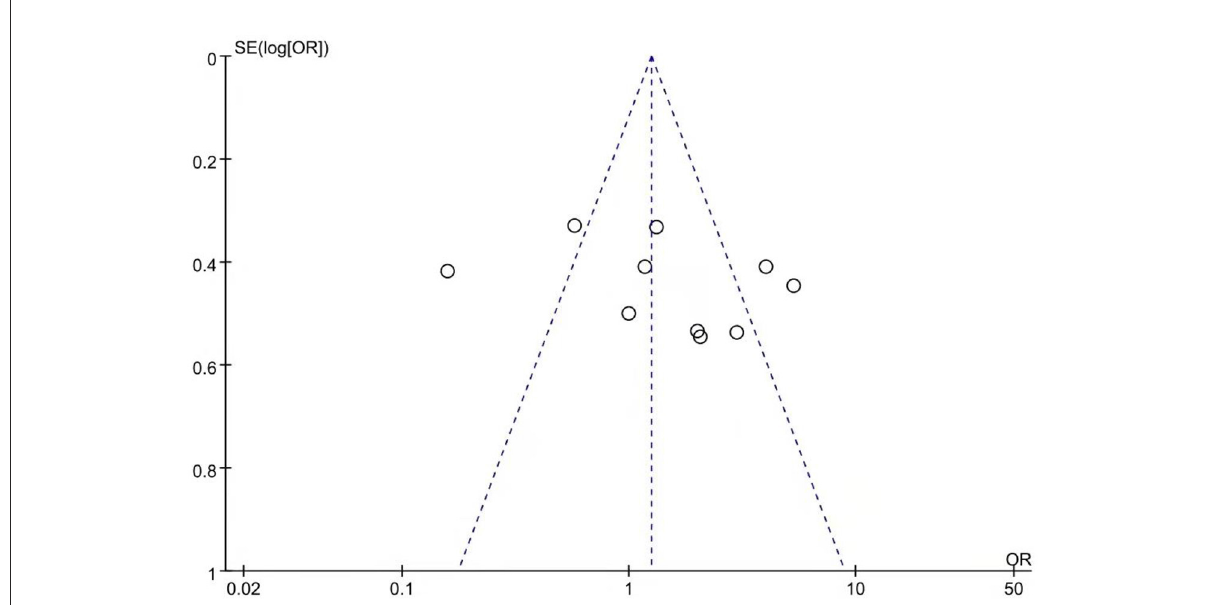
FIGURE3 Funnel plot of remission rate comparison between aripiprazole and quetiapine. There was no publication bias in these